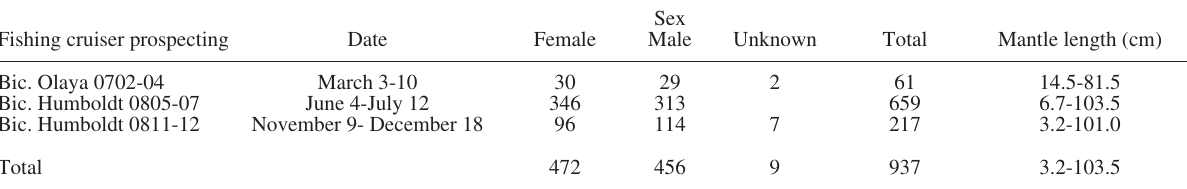
Table 1. – Summary data of jumbo squid collected in the Humboldt Current system off Peru in